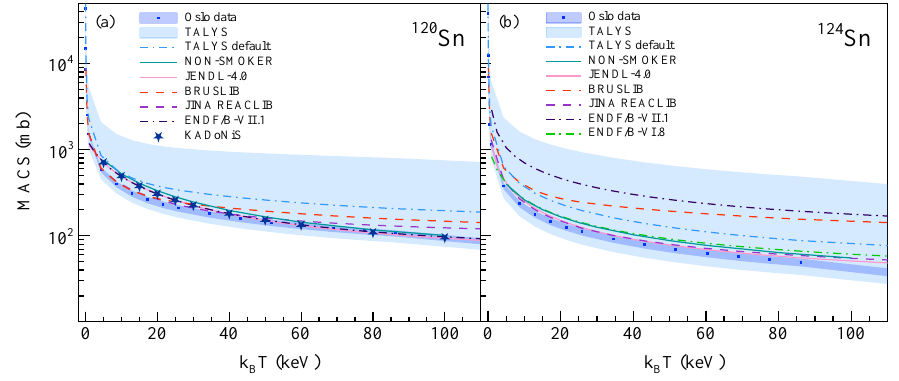
Figure 2. MACS of 120 Sn and 124 Sn obtained with the Oslo method input NLDs and GSFs compared to the span of TALYS predictions (light blue band), NON-SMOKER [7], JENDL-4.0 [8], BRUSLIB [9], JINA REACLIB [10], ENDF / B-VII.1 [11], ENDF / B-VI.8 [12], KADoNiS [13] libraries.